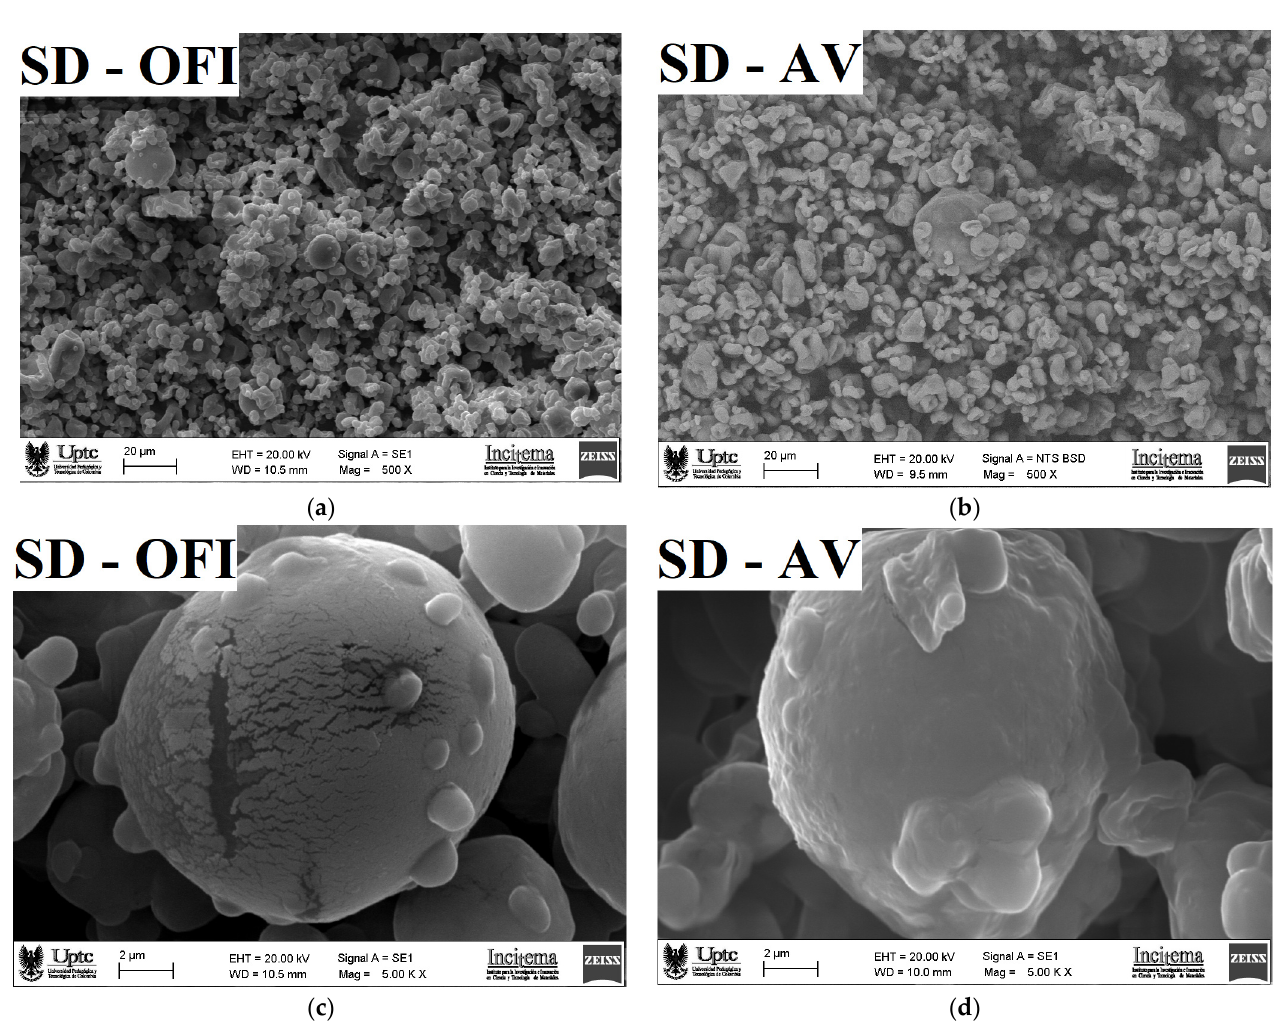
Figure 4. SEM micrograph images of the surface at 500× ( a , b ) and at 5000× ( c , d ) of SD-SD–OFI and SD-AV microcapsules, respectively.